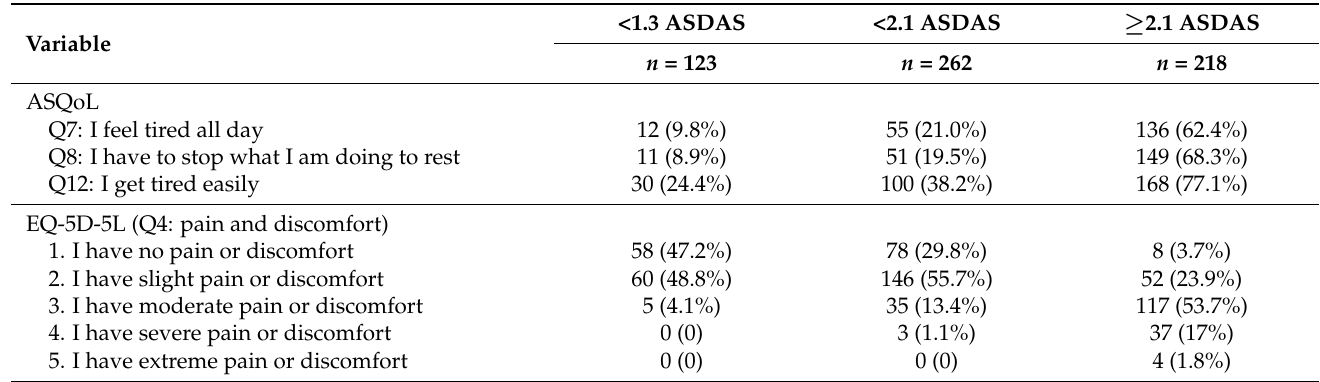
Table 3. Quality of life in patients with axial spondyloarthritis using ASQoL and EQ-5D-5L stratified by